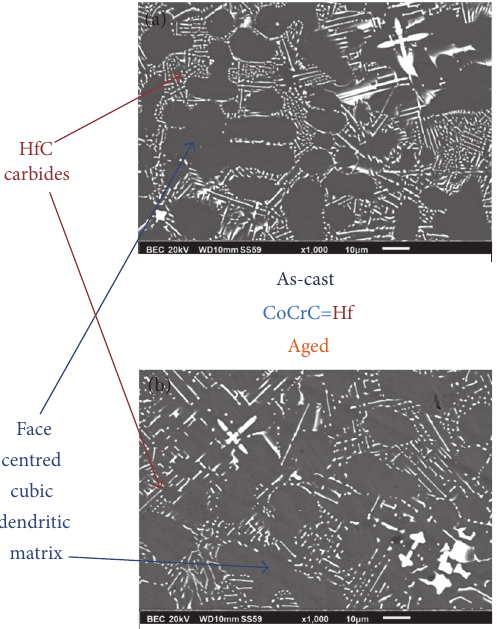
Figure 5: The as-cast (a) and aged (b) microstructure of the “CoCrC=Hf” alloy (SEM/BSE micrographs).